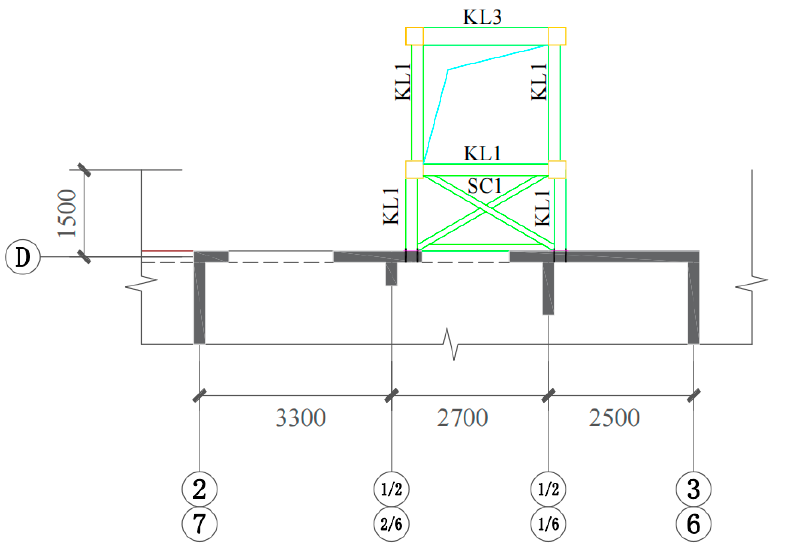
Figure 2. Details of elevator